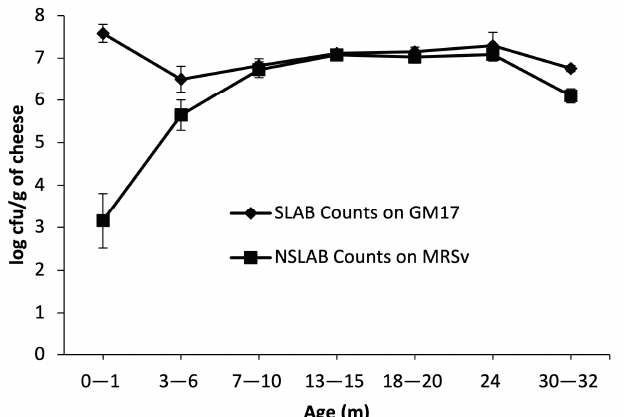
Figure 1. Mean viable counts from cheese plated on GM17 agar (diamond symbols) and MRSv agar (square symbols) to select for SLAB and NSLAB, respectively during 30–32 m of ripening in 13 trials. Values are the means and standard error (no visible bar indicates that SE is smaller than the symbol).